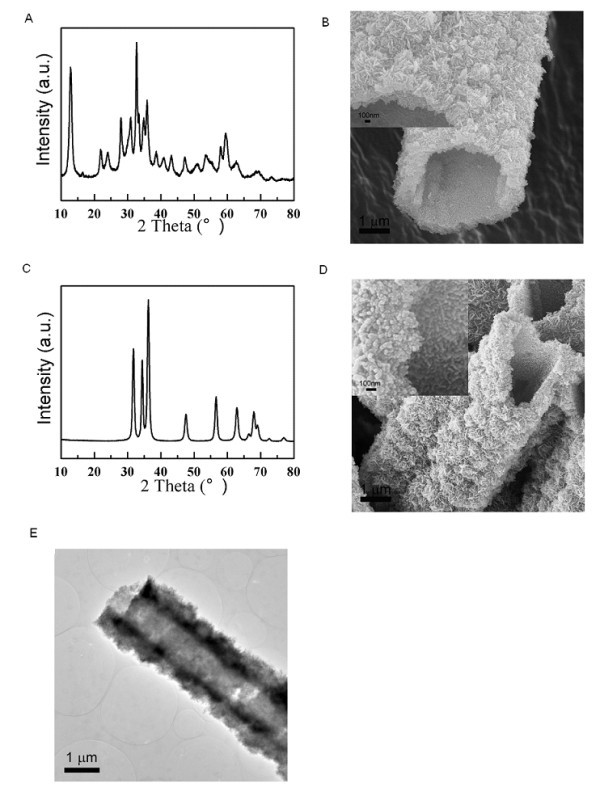
X-ray diffraction pattern, FESEM, and TEM images. (A) The X-ray diffraction pattern and (B) FESEM image of the white precipitate after the precipitation reaction between Zn(CH3COO)2·2H2O and (NH4)2CO3 with a molar ratio at 1.0:3.6. (C) The X-ray diffraction pattern, (D) FESEM image, and (E) TEM image of ZnO micro-tubes after the heat treatment of the precipitate in (A).